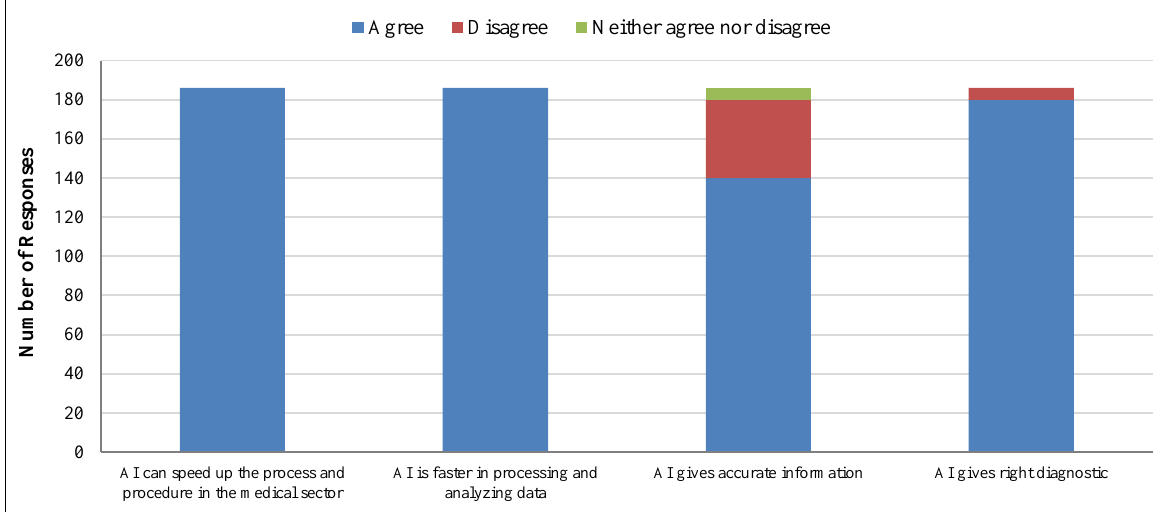
Figure 5. Advantage of AI in Saudi Healthcare sector